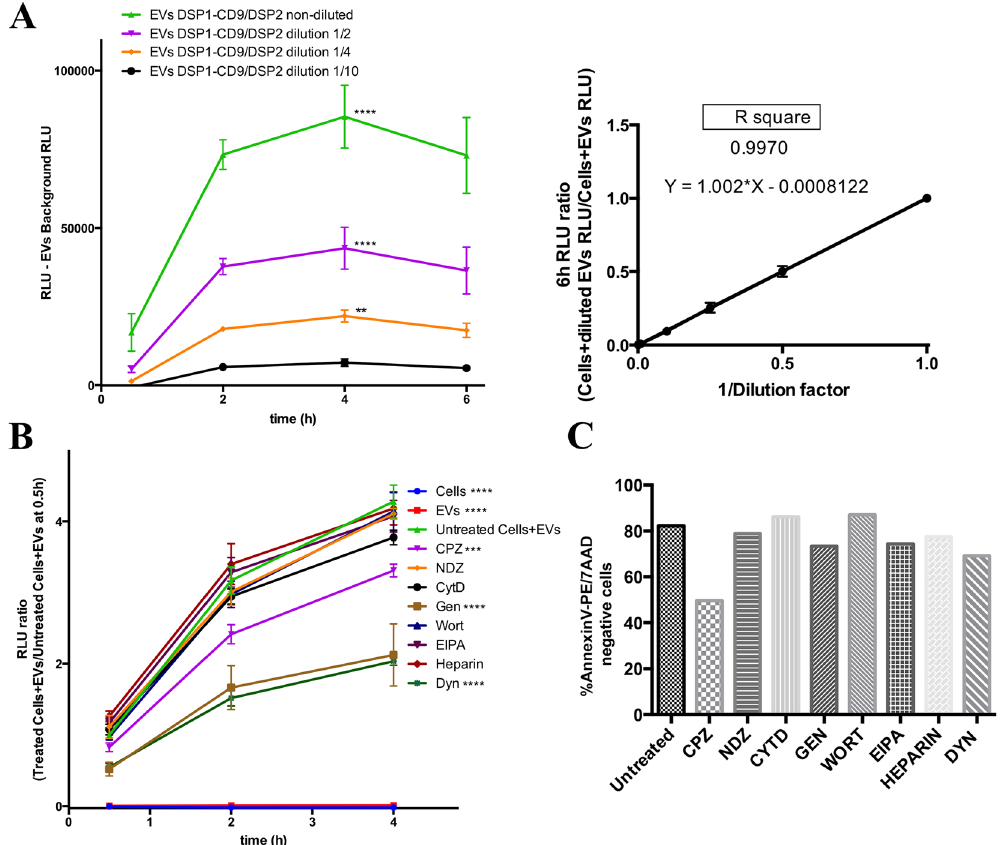
Figure 5. Proof of concept of the quantitative assay. ( A) Dose-response EV uptake assay. SUM159 target cells were incubated with several dilutions of DSP1-CD9/DSP2 EVs. 3.8 × 10 10 EVs per well were used in non- diluted samples. Statistics: **** , ** compared to negative control of DSP1-CD9/DSP2 EVs alone at 4 h; **** p < 0.0001; ** p < 0.001. Two way Anova, Tukey’s multiple comparison test, n = 3. Linear regression between the dilution factor of EVs and the RLU ratio (Cells + EVs RLU/Cells + diluted EVs) is shown in the right graph. (B) Non-transduced SUM159 target cells were loaded with Enduren, and then pretreated for 30 min with different chemical inhibitors 18 : Chlorpromazine (7.5 μ M) (CPZ); Nocodazole (10 μ M) (NDZ), Cytochalasin D (1 μ g/ml) (Cyt D), Genistein (200 μ M) (Gen), Wortmannin (1 μ M) (Wort), EIPA (75 μ M), Heparin (10 μ g/ml) and Dynasore (Dyn) (80 μ M). Then DSP1-CD9/DSP2 EVs isolated by ultracentrifugation were added, in the presence of the inhibitors. Data were normalized in each measurement time point to untreated Cells + EVs at 0.5 h. Statistics: **** , *** differences with positive control (untreated Cells + EVs); p values = < 0.0001 **** , 0.0002 *** . Two way Anova, Tukey’s multiple comparison test. n = 4. (C) Annexin/7AAD Cell Viability assay. The percentage of double negative cells for Annexin and 7AAD stainings was measured by flow cytometry after 4 h of treatment with each chemical